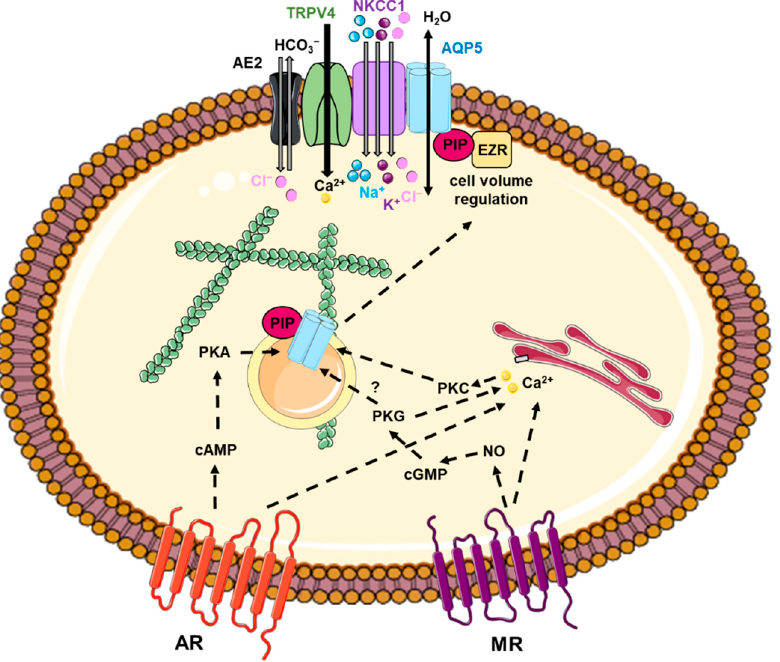
Figure 3. Mechanisms involved in AQP5 trafficking. Ach: acetylcholine; AE2: anion exchanger 2; AR: adrenergic receptor; cAMP: cyclic adenosine 3 (cid:48) ,5 (cid:48) monophosphate; cGMP: cyclic guanosine 3 (cid:48) ,5 (cid:48) monophosphate; EZR: ezrin; MR: muscarinic receptor; NKCC1: Na-K-Cl cotransporter 1; NO: nitric oxide; PIP: prolactin-inducible protein; PKA: protein kinase A; PKC: protein kinase C; PKG: protein kinase G; TRPV4: transient Receptor Potential Cation Channel Subfamily V Member 4.